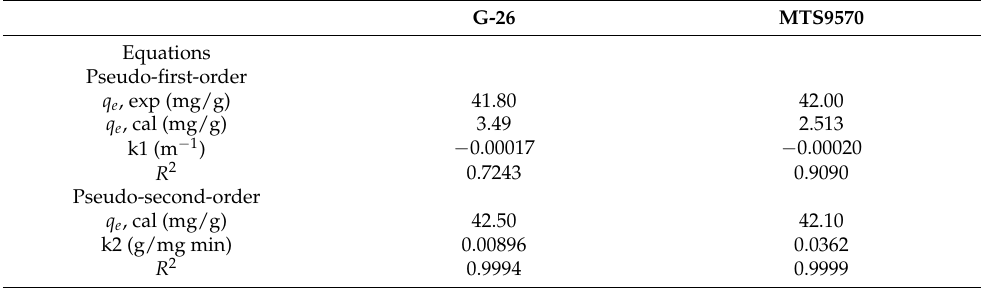
Table 4. Kinetic parameters for the adsorption of Pb(II) ions onto G-26 and